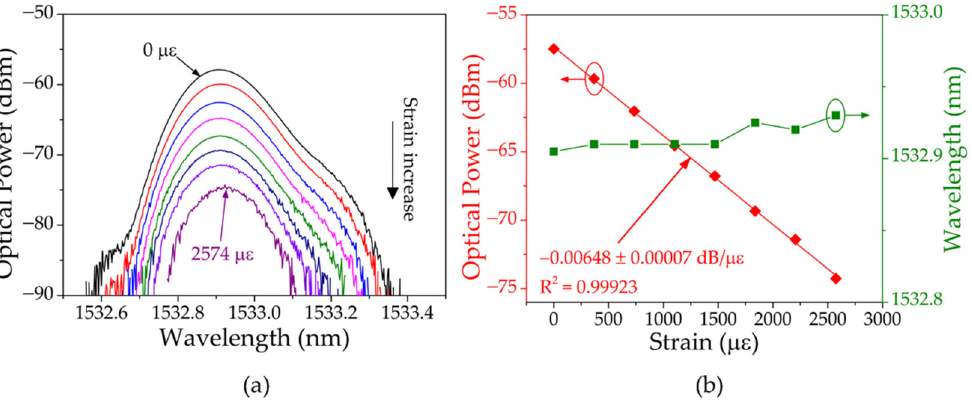
Figure 10. ( a ) Reflection spectra of the resulting signal at different levels of strain on the USFBG fiber. ( b ) Corresponding wavelength and optical power shift with increasing strain.